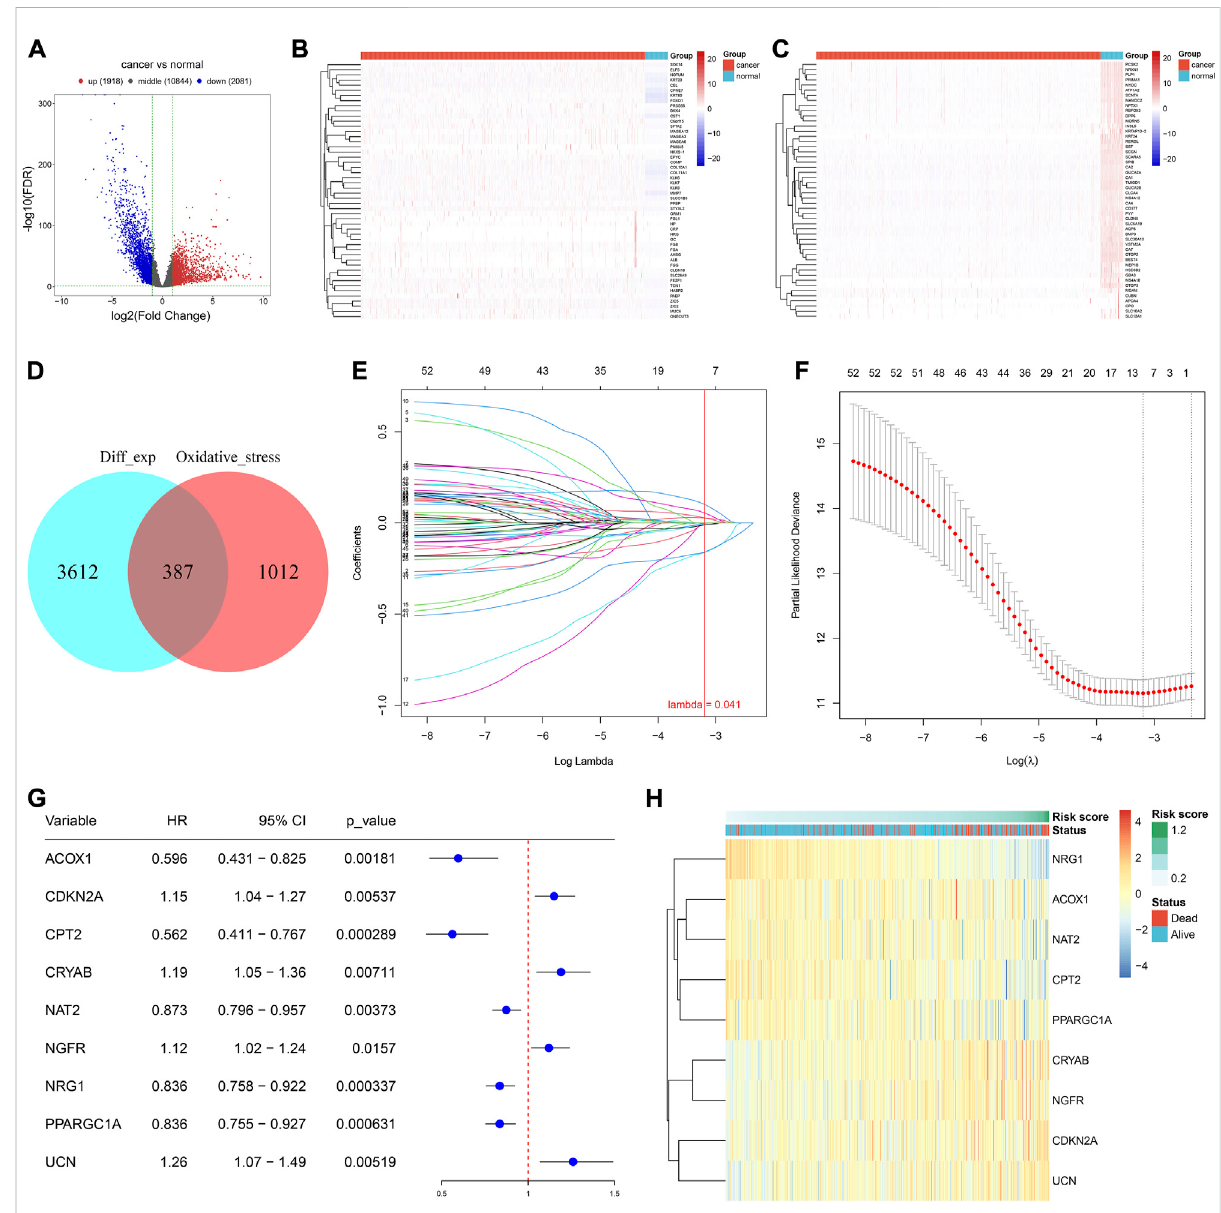
FIGURE 1 Development of an oxidative stress-related gene signature for CRC. (A) Volcano plot of the DEGs between CRC and normal tissues in the TCGA-COAD cohort. Red, up-regulated genes; blue, down-regulated genes. (B,C) Heatmaps of up- and down-regulated DEGs in CRC versus normal tissues intheTCGA-COADcohort. (D) Venn plotof theDEGs and oxidative stress-related genes. (E) Identi fi cation ofthe optimal coef fi cients ofoxidativestress-relatedgenesaccordingtotheoptimallambda.X-axisistheloglambda;Y-axisisthecoef fi cientofeachvariable. (F) Optimal partial likelihood deviance along with the optimal lambda. (G) Forest plot of the univariate cox-regression results of the oxidative stress-relevant genes within the LASSO model. (H) Expression of aforementioned genes among CRC samples. N =